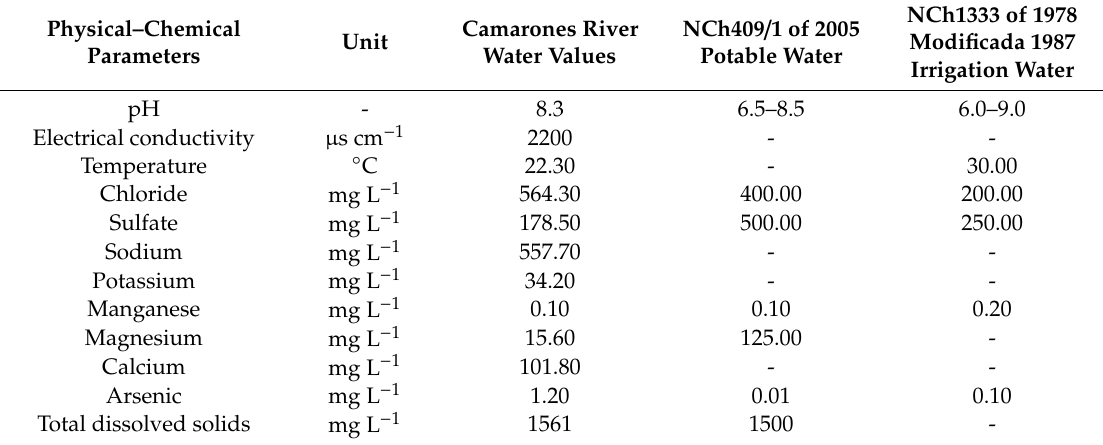
Table 1. Characterization of Camarones River water [17,18].